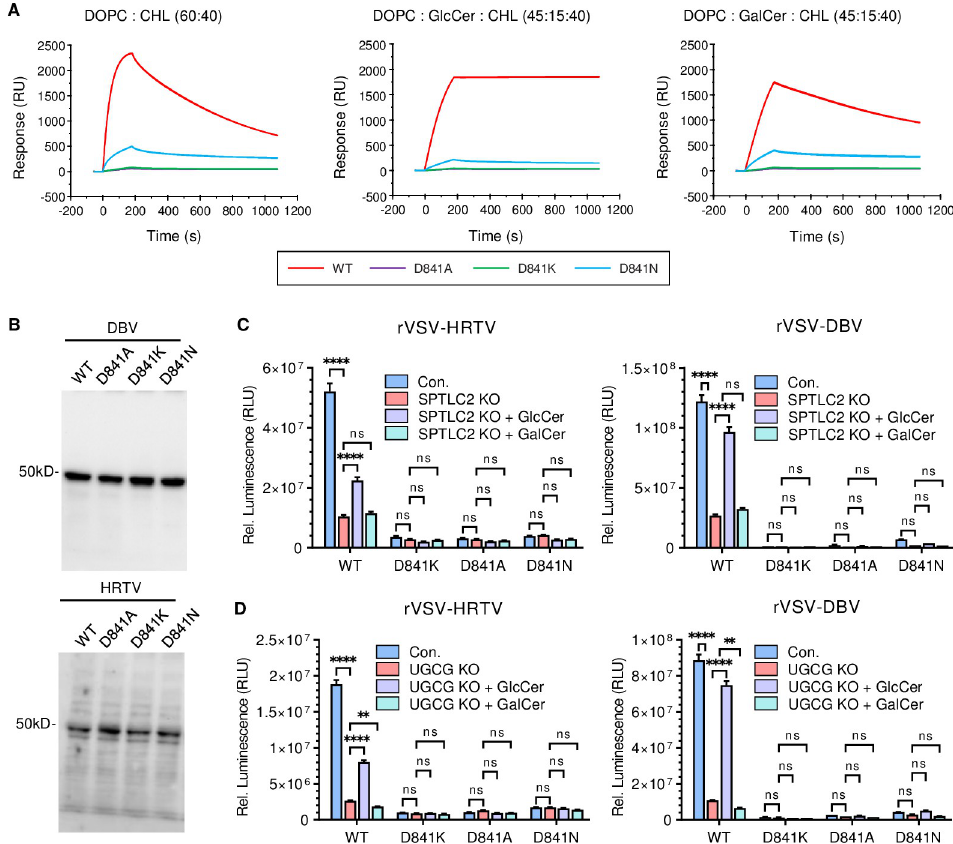
Fig 10. The D841 residue of Gc protein is crucial for its binding to lipid head group. A. SPR sensorgrams showing the interaction of Gc WT, D841A, D841K, or D841N mutant with indicated liposomes. WT and mutant Gc proteins were immobilized on the chip surface at the same response units, and the liposome (2.5 μ M) was then injected over the sensor chip. B. Expression of WT and mutant glycoproteins of DBV and HRTV. DBV or HRTV glycoprotein expression vectors were transfected into 293T cells for 24 hours and Gc expression was analyzed by immunoblots. C-D. Entry efficiency of D841 mutant-containing rVSV-HRTV or rVSV-DBV in SPTLC2- and UGCG-KO cells. SPTLC2-KO and UGCG-KO 293T cells were cultured in media supplemented with 50 μ M GalCer or GlcCer for 24 hours before viral infection. Luciferase activity was measured at 18 hours post-infection. Control cells without glycosphingolipids supplement was included as comparison. Data shown are means ± SEM from representative experiments (n = 3 technical replicates). P values were determined by two-way ANOVA with Dunnett’s multiple comparison tests. ���� , P < 0.0001; ��� , P < 0.001; �� , P < 0.01; � , P < 0.05.